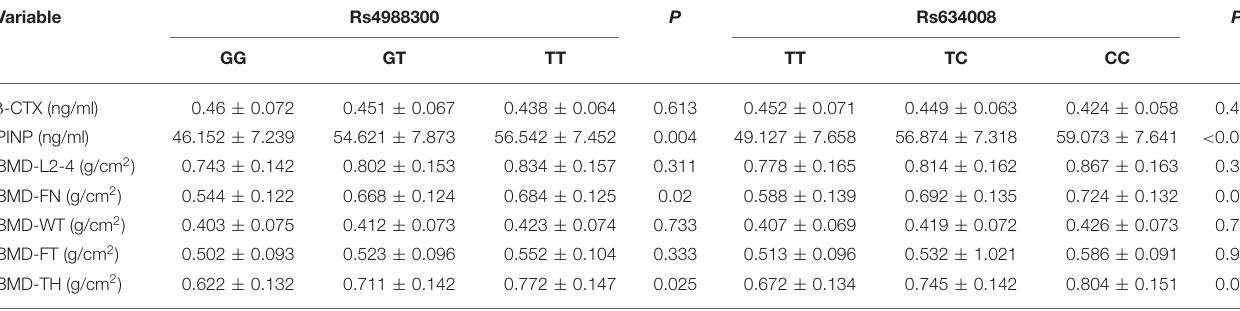
TABLE 7 | Relationships of SNPs genotyped with BTMs and BMDs in male with osteoporotic fracture.